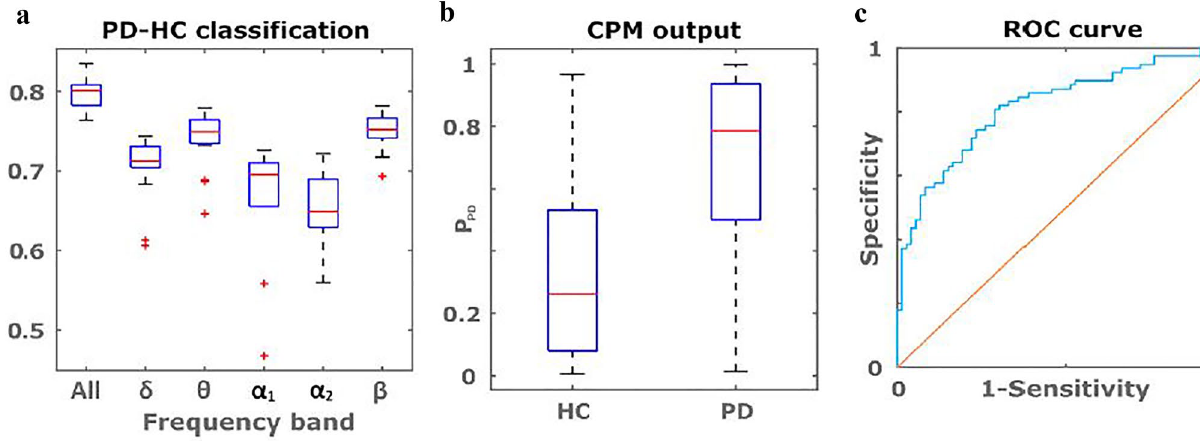
Figure 3. ( a–c ) PD-HC classification performance. ( a ) PD-HC classification using TBPC pro- files from all frequency bands together as well as for each frequency band separately. Box-plots indicate the distribution of AUC values obtained using different feature selection thresholds. ( b ) P PD scores from the CPM classifier using TBPC profiles from all frequency bands together, averaged over all evaluated feature detection thresholds. ( c ) ROC value (0.8) is gives the probability to be P PD .